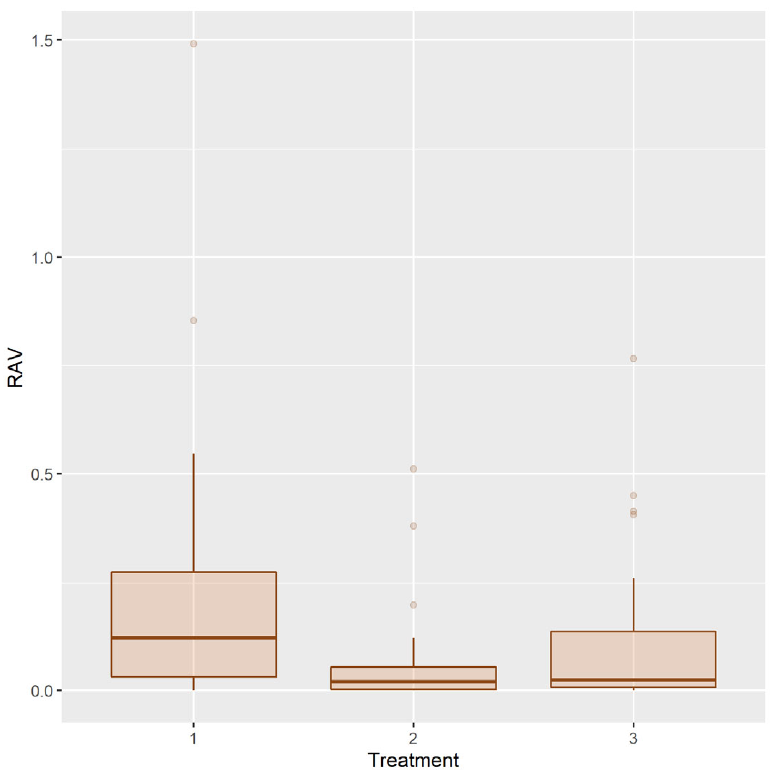
Figure 6. Distribution of the residual adhesive volume after treatments 1, 2, 3. RAV has very asymmetrical distribution in all three treatment groups. To achieve normality of distribution, power function transformation was used. With power 0.125, data does not reveal statistically significant difference from normal distribution ( p = 0.375, 0.341, 0.353 in groups 1, 2, 3, respectively). Histograms of original and transformed RAV are shown in Figure 7.